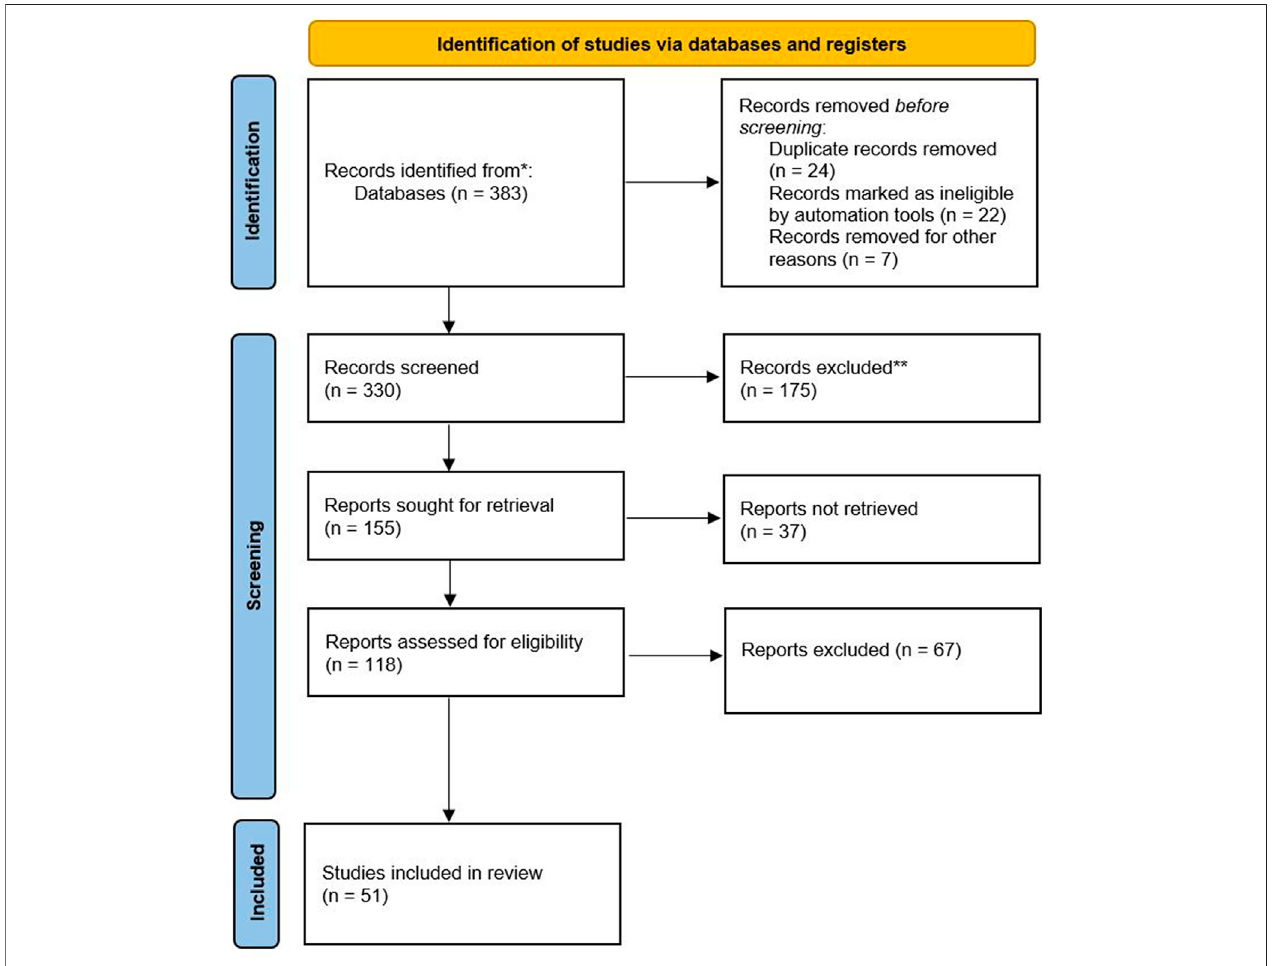
FIGURE 1 | PRISMA 2020 fl ow diagram to represent the article selection process. Figure with yellow (identi fi cation of studies via databases and registers), blue (identi fi cation, screening and included) and white.